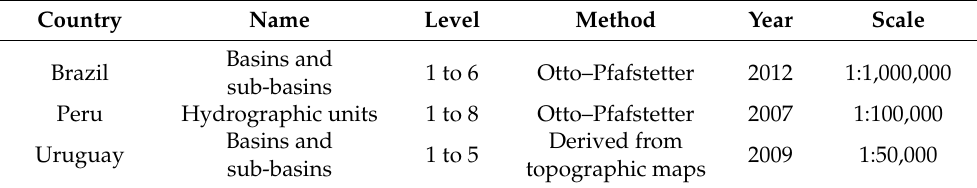
Table 1. Metadata of the downloaded shapefiles.